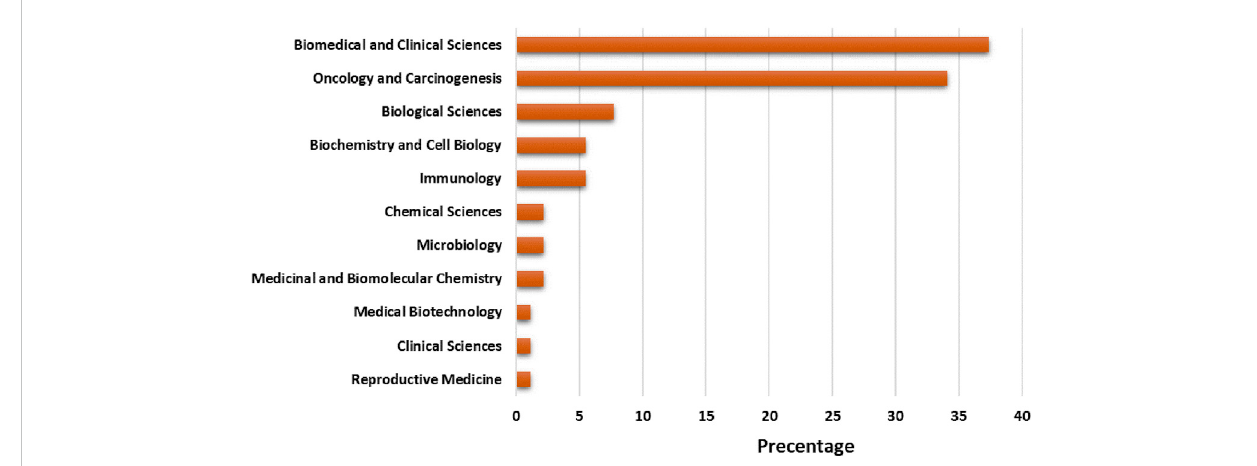
FIGURE 4 Trend of productivity by countries in terms of number of publications in the fi eld of exosome and EOC.